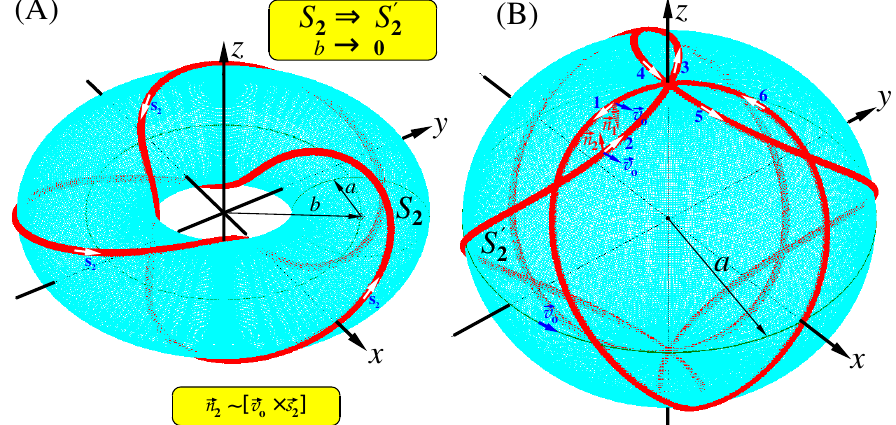
Figure 12. ( A ). Red string S 2 having parameters ω 0 = 1, φ 0 = 0, and ω 1 = 2/3, φ 1 = π is drawn on surface of the torus having radiuses a = 1, b = 2. The current flowing along the string is drawn by white arrows and marked by blue letters s 2 ; ( B ). Red string S (cid:48) drawn on the surface of the doubled sphere with radiuses a = 1, b = 0. The current flowing along this 2 string is drawn by white arrows and marked by blue numbers 1, 2, 3, 4, 5, 6. Blue arrows point rotation of the sphere about axis z with the orbital velocity (cid:126) v o . The cross product of the velocity (cid:126) v o by the current gives the normal to the sphere surface that is oriented either inside the surface (punctuated red arrow (cid:126) n 1 ) or outside it (red arrow (cid:126) n 2 ). What happens if we apply the CPT transformation to these strings? First, the P (parity) transformation is equivalent to the inversion of the spatial axes. Observe that the positions of the red and blue strings do not change. Whereas the green string moves on the phase φ 0 = π from its initial position, see the right figure in Figure 13. As for the C (charge conjugation) transformation, it changes colors red to cyan, blue to yellow, green to pink, which is equivalent to the change of charges 2 e /3 → − 2 e /3 and − e /3 → e /3. The T (time reversal) transformation changes the direction of the currents along the strings. It means that a transformed object is the